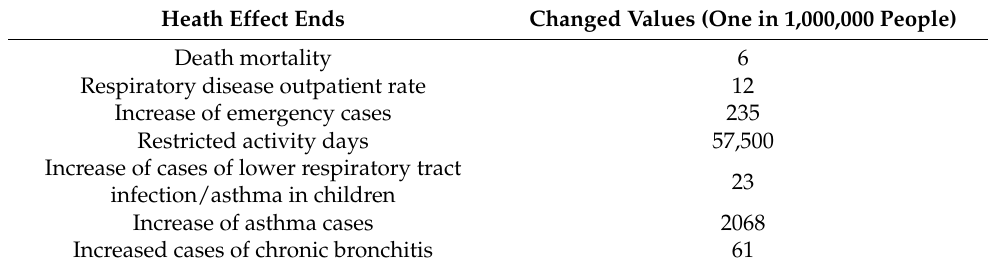
Table 6. Dose-response functions between the changes in PM 10 concentration and the health